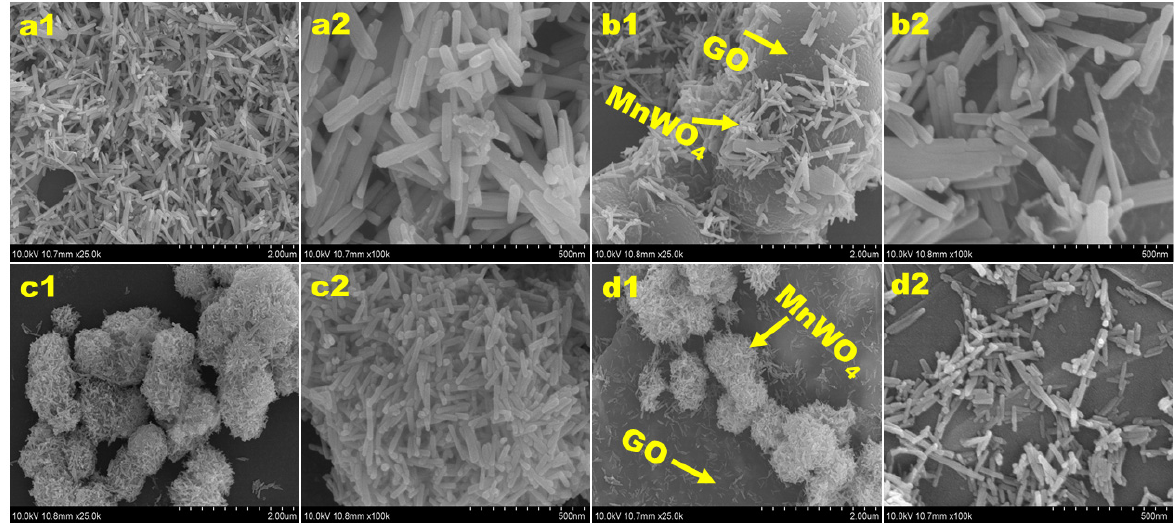
Figure 4. SEM image of hydrothermally synthesized electrocatalysts. MW-7 ( a1 , a2 ); MW@GO-7 ( b1 , b2 ); MW-12 ( c1 , c2 ); and MW@GO-12 ( d1 , d2 ).